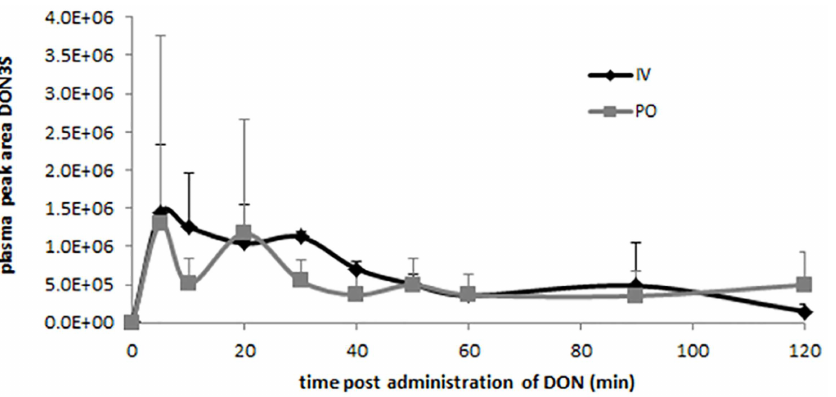
Fig 2. Peak area of deoxynivalenol-3alpha-sulphate (DON3S) at different time points after intravenous (IV) (n = 5) and oral (PO) (n = 5) administration of 0.3 mg DON/kg body weight to pigeons, as determined by high resolution-mass spectrometry. Valuesare presented as means +